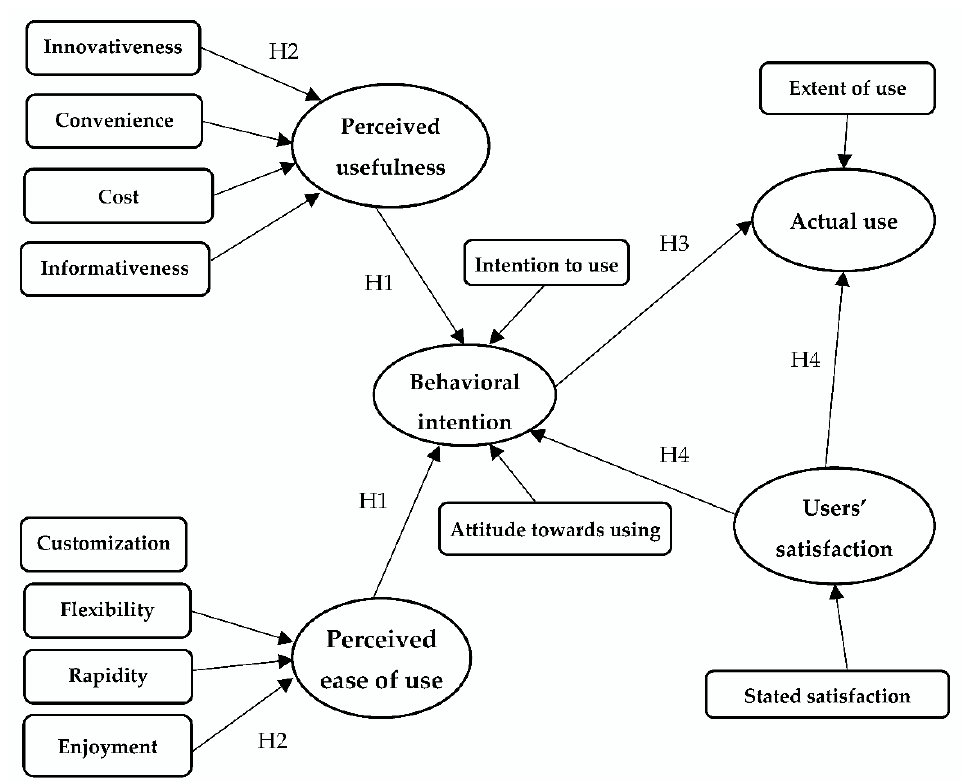
Figure 2. Theoretical model. Source: author’s construction based on [57,59–62].